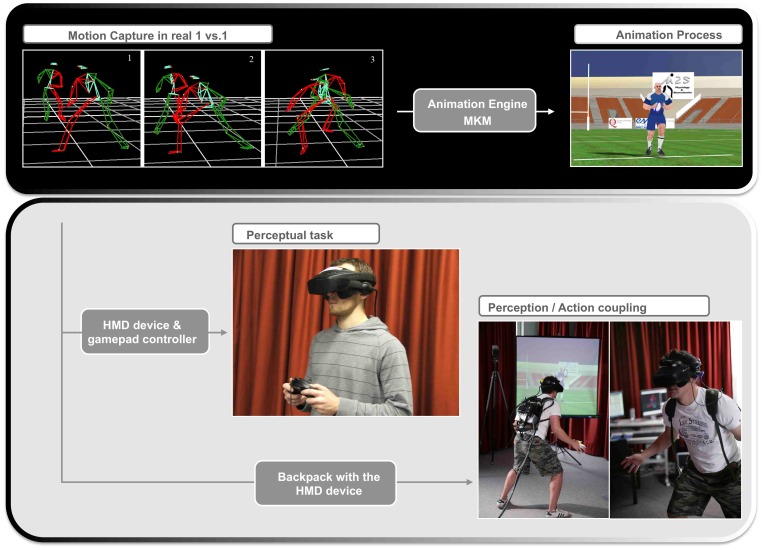
Top panel. Real movement data recorded from attacker versus defender duels are used to form the basis of the movement of the animated virtual attacker.Bottom panel: The two immersive tasks in a virtual rugby environment used a Head Mounted Display with a wireless motion tracker. This gave the participants a fully (360 degree visual field) immersive experience. In the Perception Only task, a gamepad was used to record the participant’s predictions about final running direction (by pressing left or right buttons) at the different occlusion times. In the Perception and Action experiment, participants wore a backpack containing the control unit for the HMD so that they not only had a fully immersive experience but that they were also free to move (up to 3 m to the left or right) to intercept the virtual attacker. Their movements were recorded using the Qualisys motion capture system.